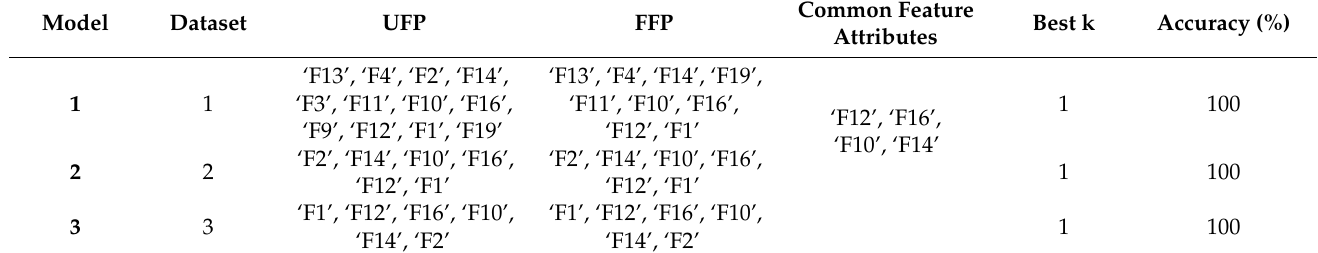
Table 5. Diagnostic performance of the proposed model.